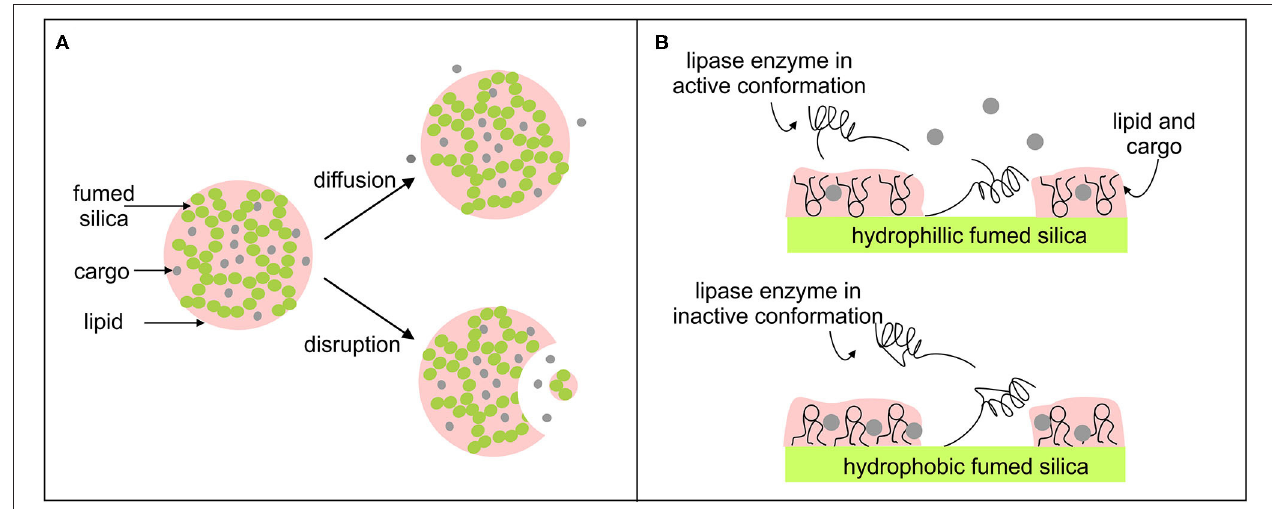
FIGURE 2 | (A) Schematic of the release of encapsulated ingredients (cargo) from fumed silica organogels during digestion by diffusion through the thickened oil and disruption of the particle network. (B) Schematic of how the interplay between the surface chemistry of the fumed silica and the conformation of the enzyme and lipid molecules on the silica surface may affect cargo